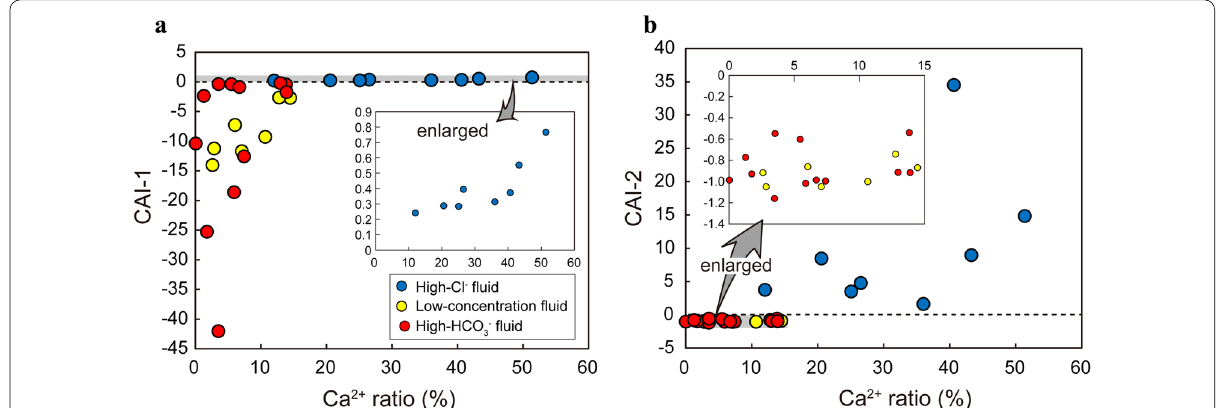
Fig. 4 Biplot diagram between Ca 2 + ratio and chloro-alkaline indices. a, b Plot diagrams compare for CAI-1 and CAI-2, respectively, three types of groundwaters from hot spring sites, High-Cl − , Low-concentration, and High-HCO 3 − fluids. Ca 2 + ratio denotes proportion of calcium ion among four major cations (Na + , K + , Ca 2 + and Mg 2 + ) in milliequivalent